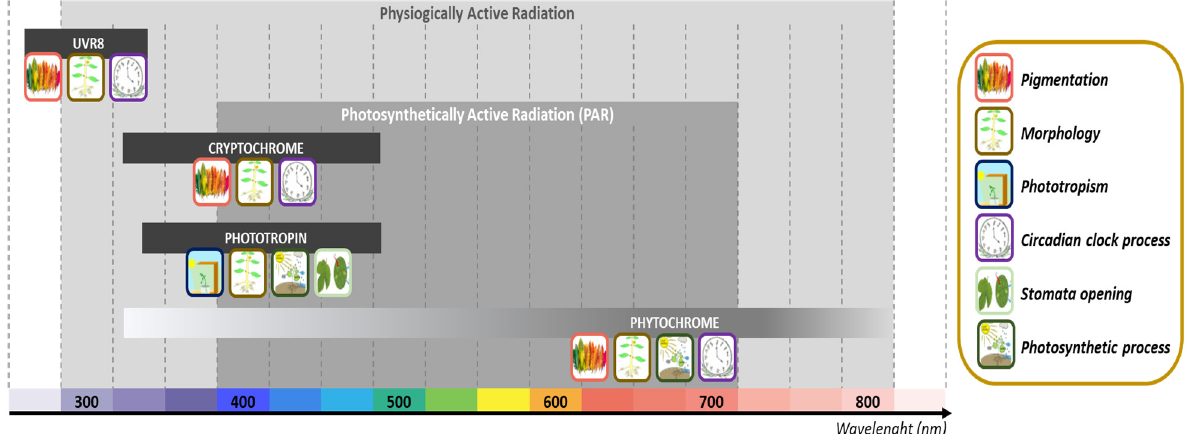
Figure 2. Photoreceptor absorption bands in plants and their processes (adapted from [115]). Absorbing photons activate different types of photoreceptors not just in the PAR domain but also in the UV and far-red regions. Each absorption band and photoreceptor couple are engaged in a different physiological response that may be essential for biomass and secondary metabolite synthesis, such as pigmentation, morphology, phototropism, circadian clock process, stomata opening, or photosynthetic activity.